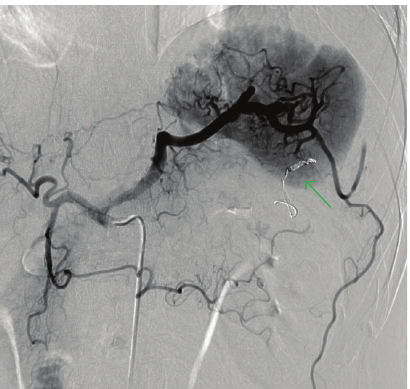
Figure 3: Celiac arteriography after embolization revealed arrested bleeding from the omental artery. Microlocoils are placed in a left gastroepiploic artery